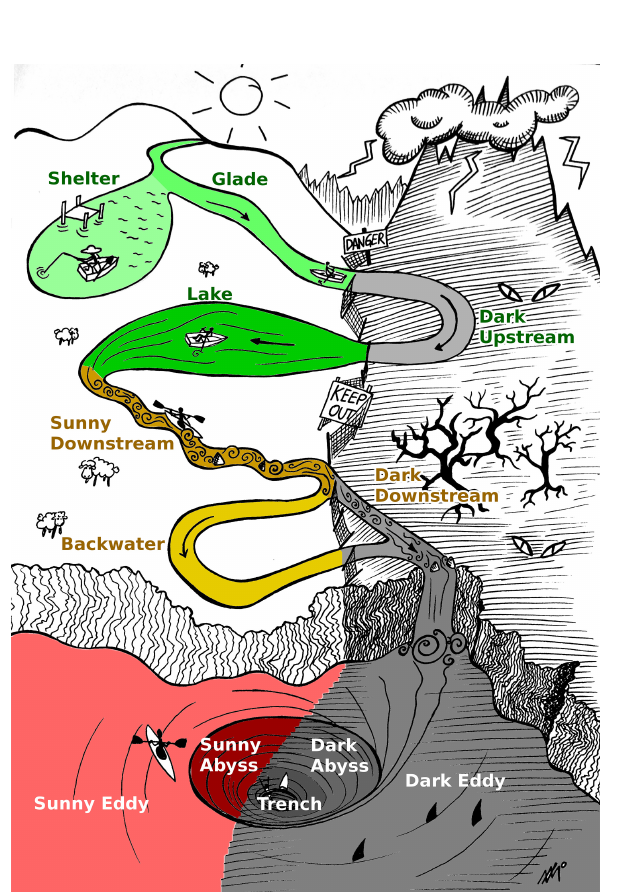
Figure 1. Metaphorical summary of concepts introduced in Sect. 1.1 (“Metaphorical framework”) inspired by Schellnhuber (1998). It depicts a river flowing from the mountains to the sea while go- ing through sunny (left) and dark parts (right) where humanity can float and row on a boat. In the shelter , no rowing is needed to re- main in the sun. One can row against the stream direction in slowly flowing parts, shown with long thin arrows, but in fast parts marked with swirls this is not possible. This setting gives rise to a number of qualitatively different regions of the system’s state space that can be found in any manageable dynamical system as well: upstream regions such as glades and lakes from where the shelter can be reached, downstream regions such as the backwaters from where one can at best stay in the sun by management, and several types of worse regions, all labelled here and explained in the text. See also Figs. 2 and